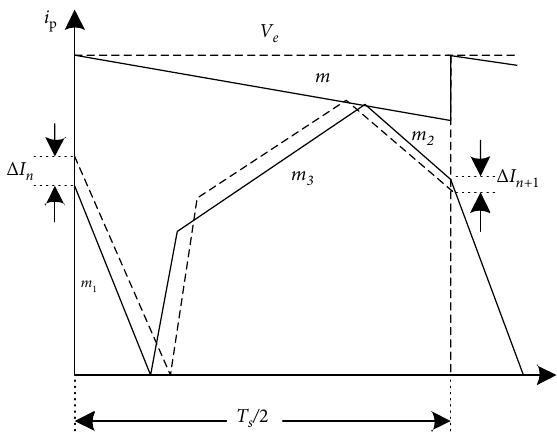
Figure 2: Waveform of primary current 𝑖 p of the transformer before and after